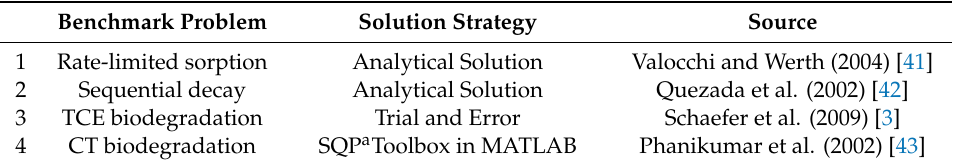
Table 1. Summary of the benchmark problems used for testing the performance of PGA along with their solution strategy employed and their